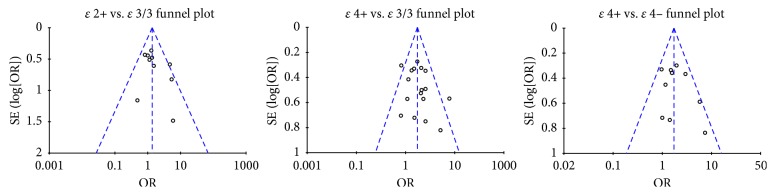
Funnel plots of ε2+ vs. ε3/3, ε4+ vs. ε3/3, and ε4+ vs. ε4−.